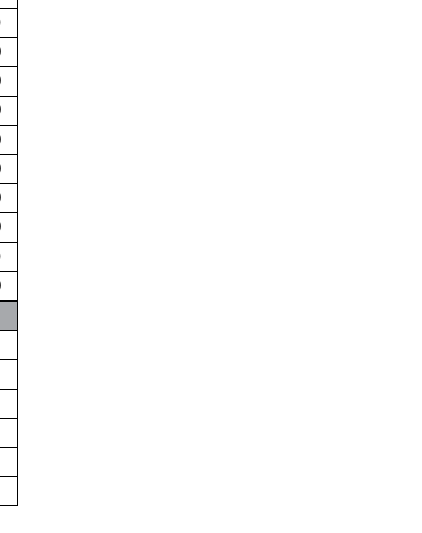
Table 1. Destribution of the patients’